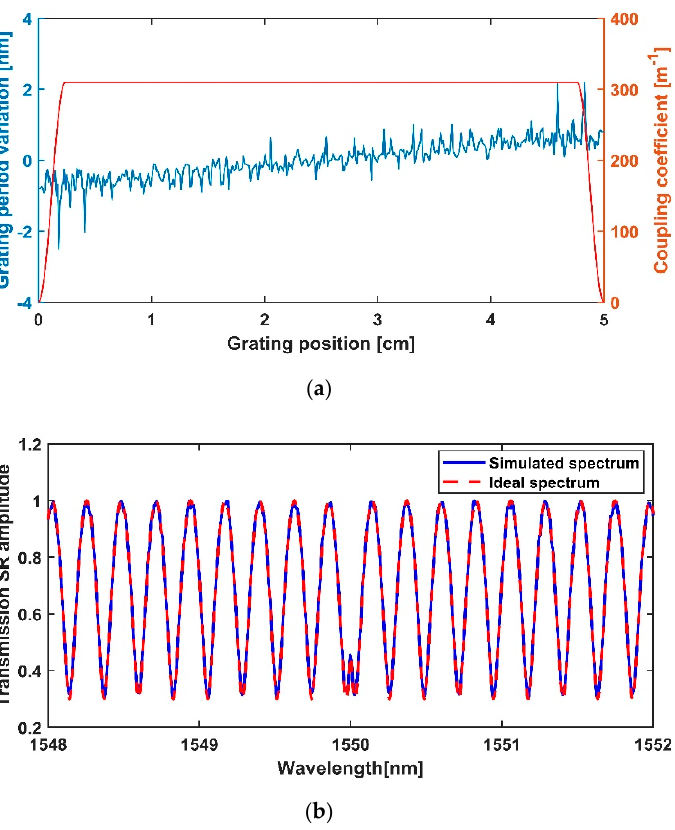
Figure 4. ( a ) Grating period (blue line) and coupling coefficient (red line) of the designed 1.5th-order PHT and ( b ) comparison between ideal spectrum (dashed red line) and simulated spectrum (blue line).